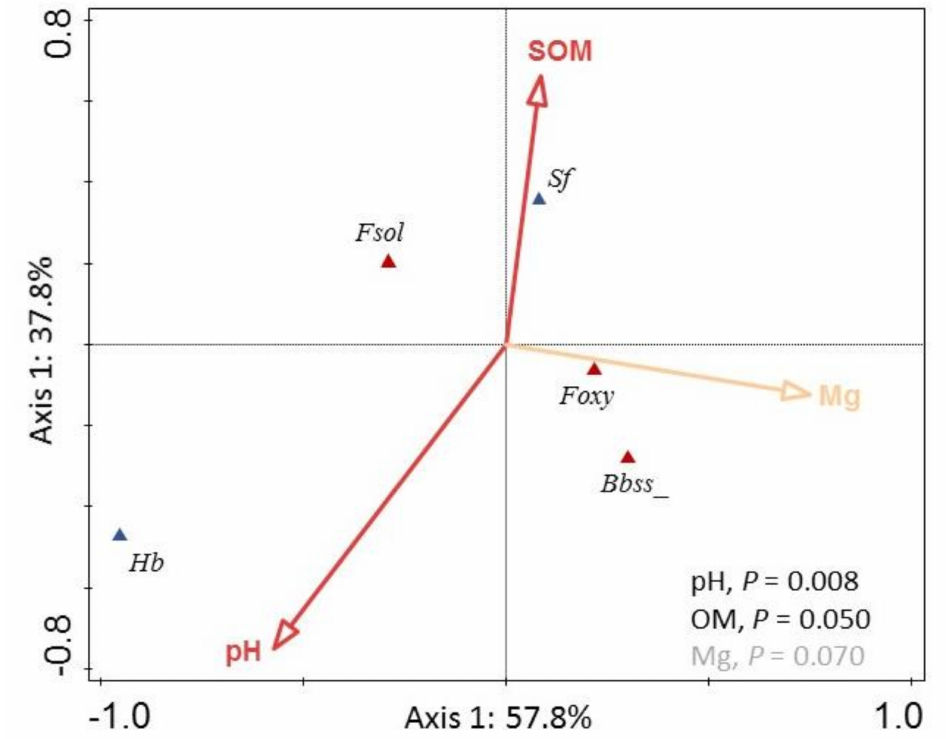
Figure 5. Canonical correspondence analysis depicting the regional distribution and relationships between significant abiotic factors and soil organisms ( p < 0.05 in red and p < 0.1 in orange) in the Algarve region. Codes for abiotic factors (arrows): soil organic matter (SOM), soil pH (pH) and Mg content (Mg). Codes for biotic factors (triangles): the entomopathogenic fungi species (brown triangles) Beauveria bassiana (Bbss), Fusarium solani (Fsol) and F. oxysporum (Foxy); and the entomopathogenic nematodes (blue triangles) Heterorhabditis bacteriophora (Hb) and Steinernema feltiae